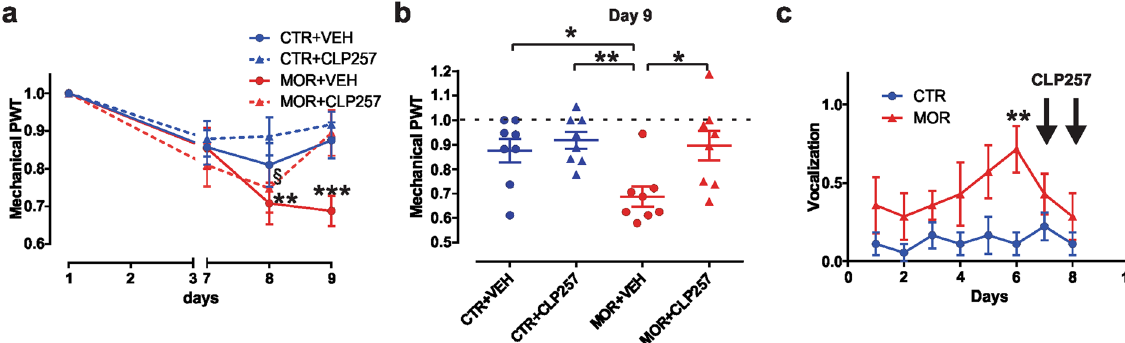
Figure 4. Effect of CLP257 on established MIH. ( a ) Effect of CLP257 on PWT in saline- (blue) and morphine- treated (red) rats ( n = 8 per group). A single dose of CLP257 (100 mg/kg) or VEH were administered i.p. at day 9. Morphine-treated rats developed mechanical sensitivity at day 8 (repeated measure ANOVA; Bonferroni’s post-hoc day 8 vs . day 1: MOR + VEH ** P < 0.01; MOR + CLP257, § P < 0.05) which was reversed by CLP257 injection at day 9 (Bonferroni’s post-hoc day 9 vs . day 1: MOR + VEH *** P < 0.001; MOR + CLP257, P >